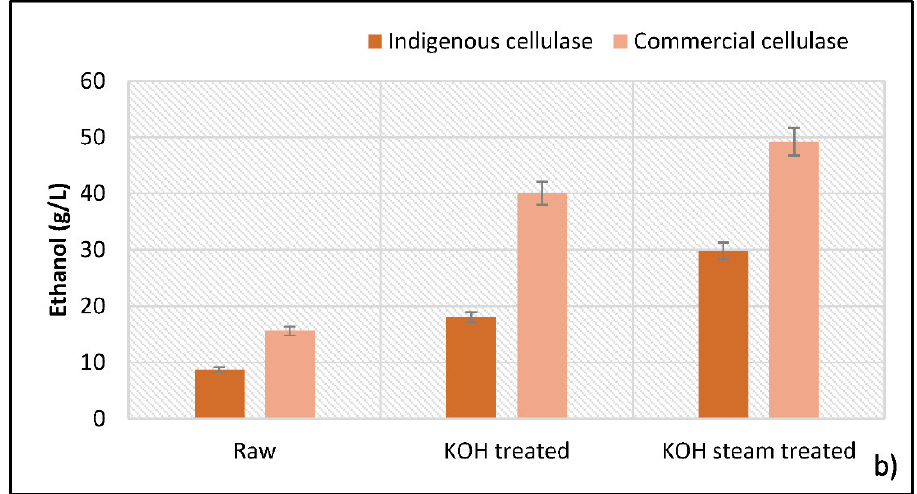
Figure 8. Separate hydrolysis and fermentation. ( a ) Saccharification after 24 h, ( b ) ethanol produced after 96 h.